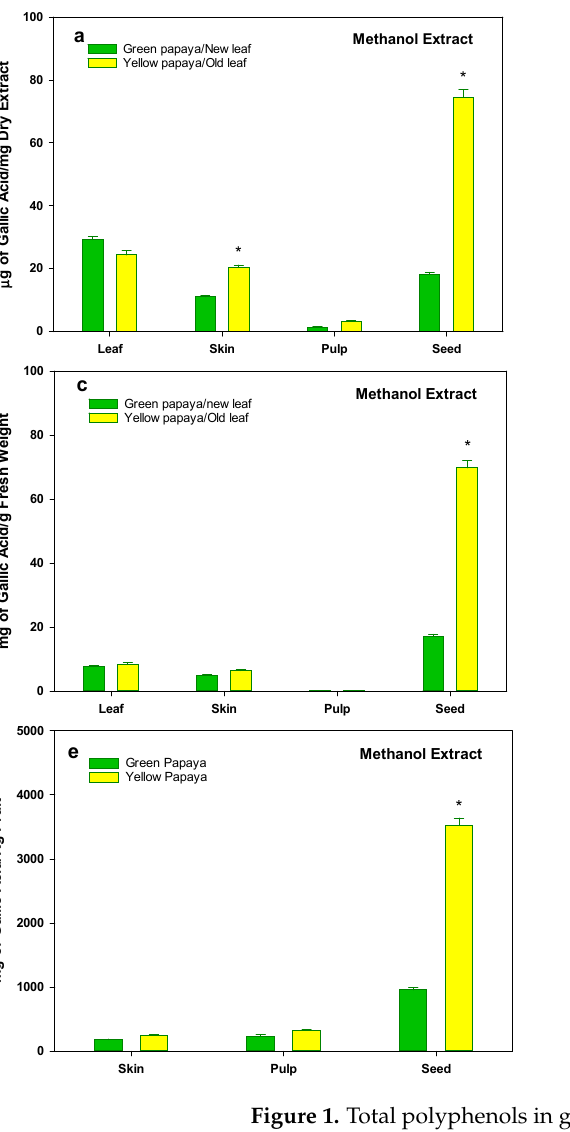
using Folin and Ciocalteu’s (FC) reagent. Total phenolic content was determined using Gallic acid as a standard. Analyses were performed in triplicate and data were expressed as milligrams of Gallic acid equivalents (GAE)/g of dried sample or fresh sample or in a 1 kg fruit. The statistical analysis was performed using Student’s t test between green and yellow papaya. The significant difference is represented by “*” at p < 0.05.